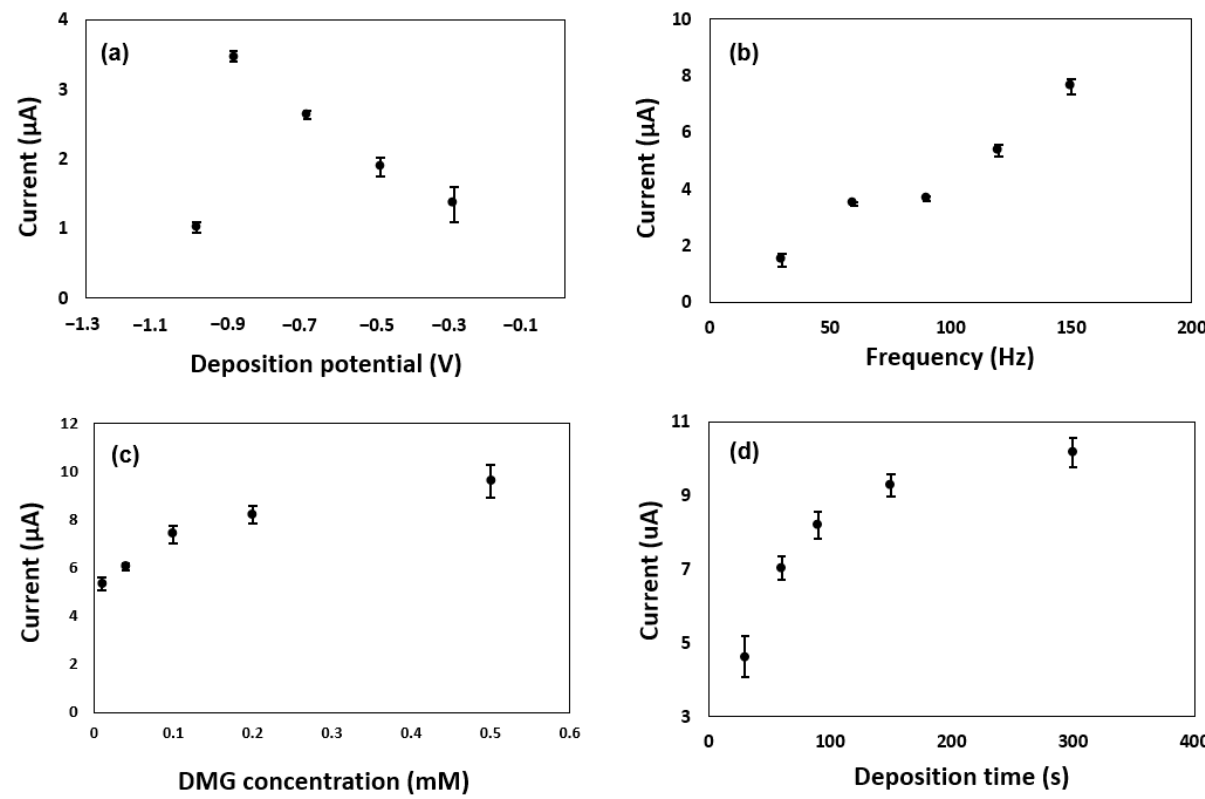
Figure 1. Optimization of SWAdCSV operating parameters for Ni(II) detection: ( a ) deposition potential, ( b ) frequency, ( c ) DMG concentration, and ( d ) deposition time. SWAdCSV was performed in 0.1 M ammonia buffer solution at pH 9.2 containing 50 µ g L − 1 of